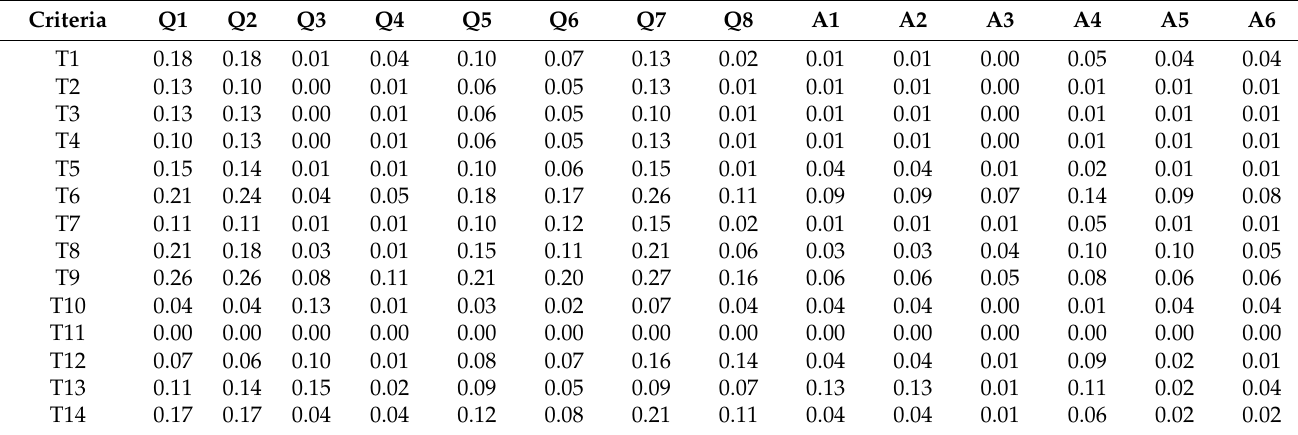
Table 3. Matrix of the total impact of PV criteria. Own